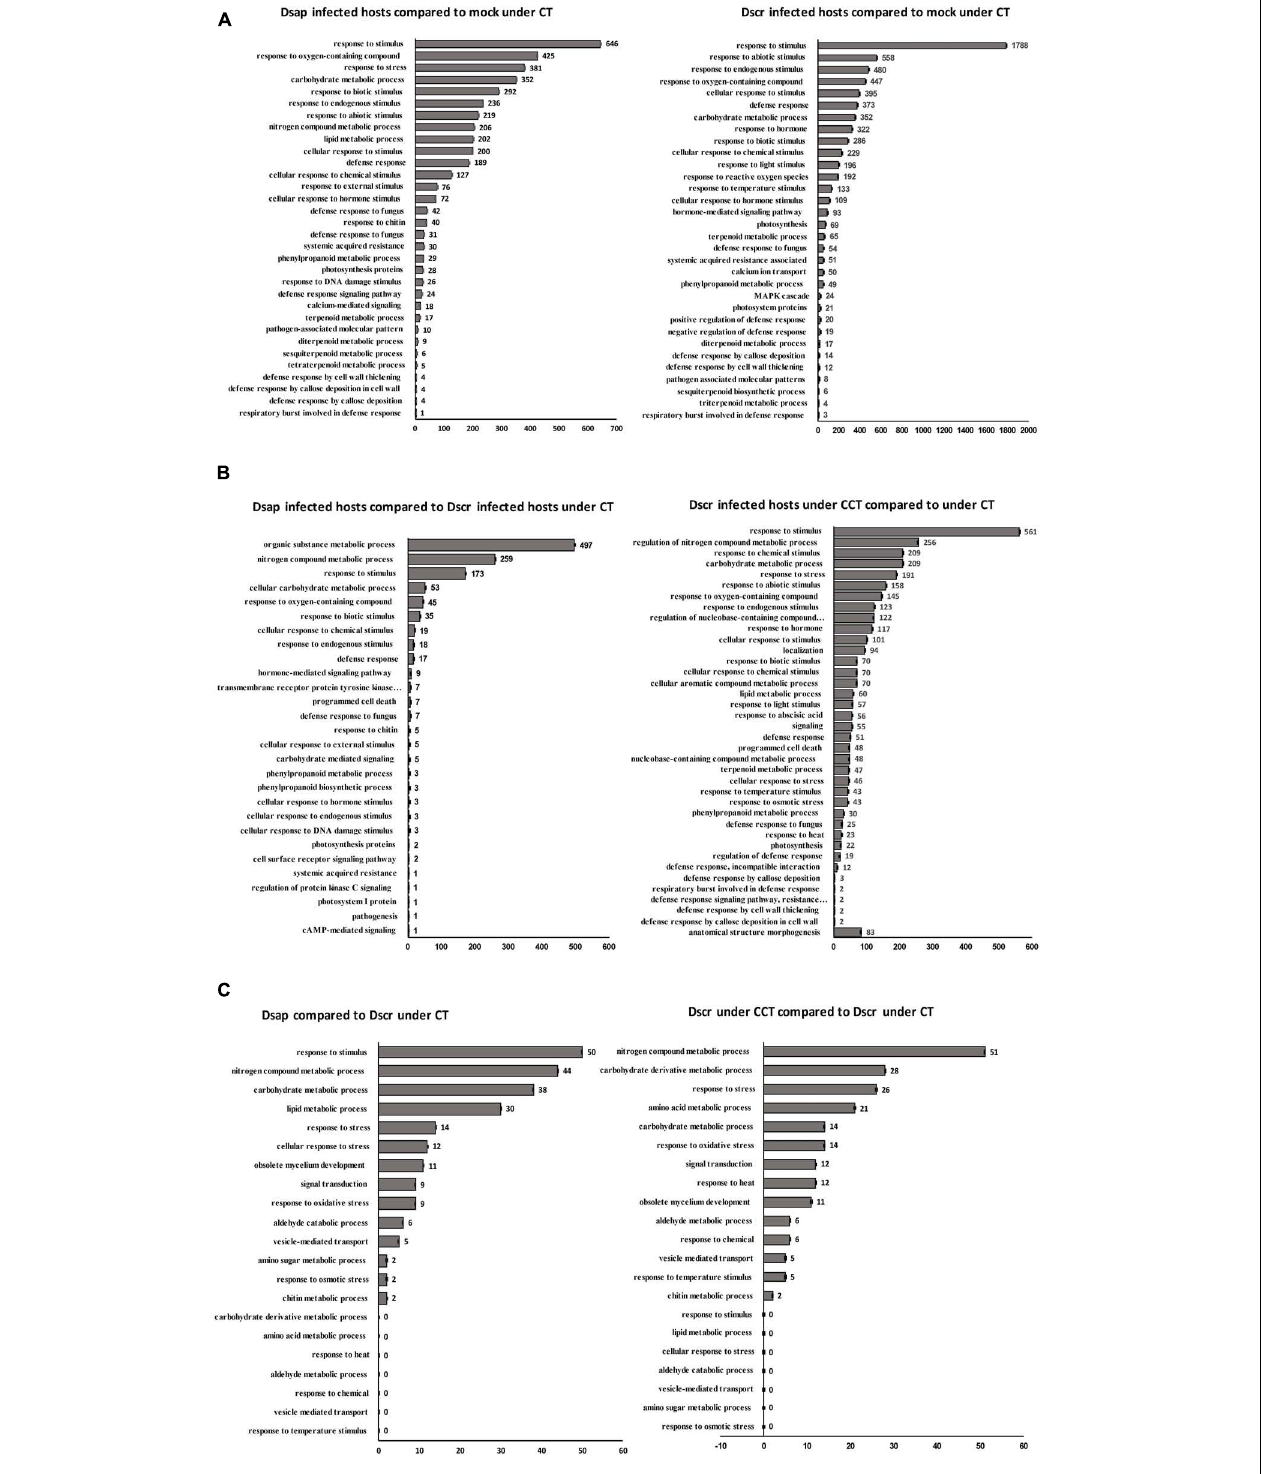
FIGURE 6 | (A) Significant host gene functions annotated using Blast2GO. X -axis: number of differentially expressed genes; y -axis: ontology associated functions. Left: comparison 1; right: comparison 2 ( Figure 1 ). (B) Significant host gene functions annotated using Blast2GO. X -axis: number of differentially expressed genes; y -axis: ontology associated functions. Left: comparison 3; right: comparison 4 ( Figure 1 ). (C) Significant pathogen gene functions annotated using Blast2GO. X -axis: number of differentially expressed genes; y -axis: ontology associated functions. Left: comparison 3; right: comparison 4 ( Figure 1 ). CT, control treatment; CCT, climate change treatment; Dsap, Diplodia sapinea ; Dscr, D. scrobiculata ; Mock, mock inoculated.